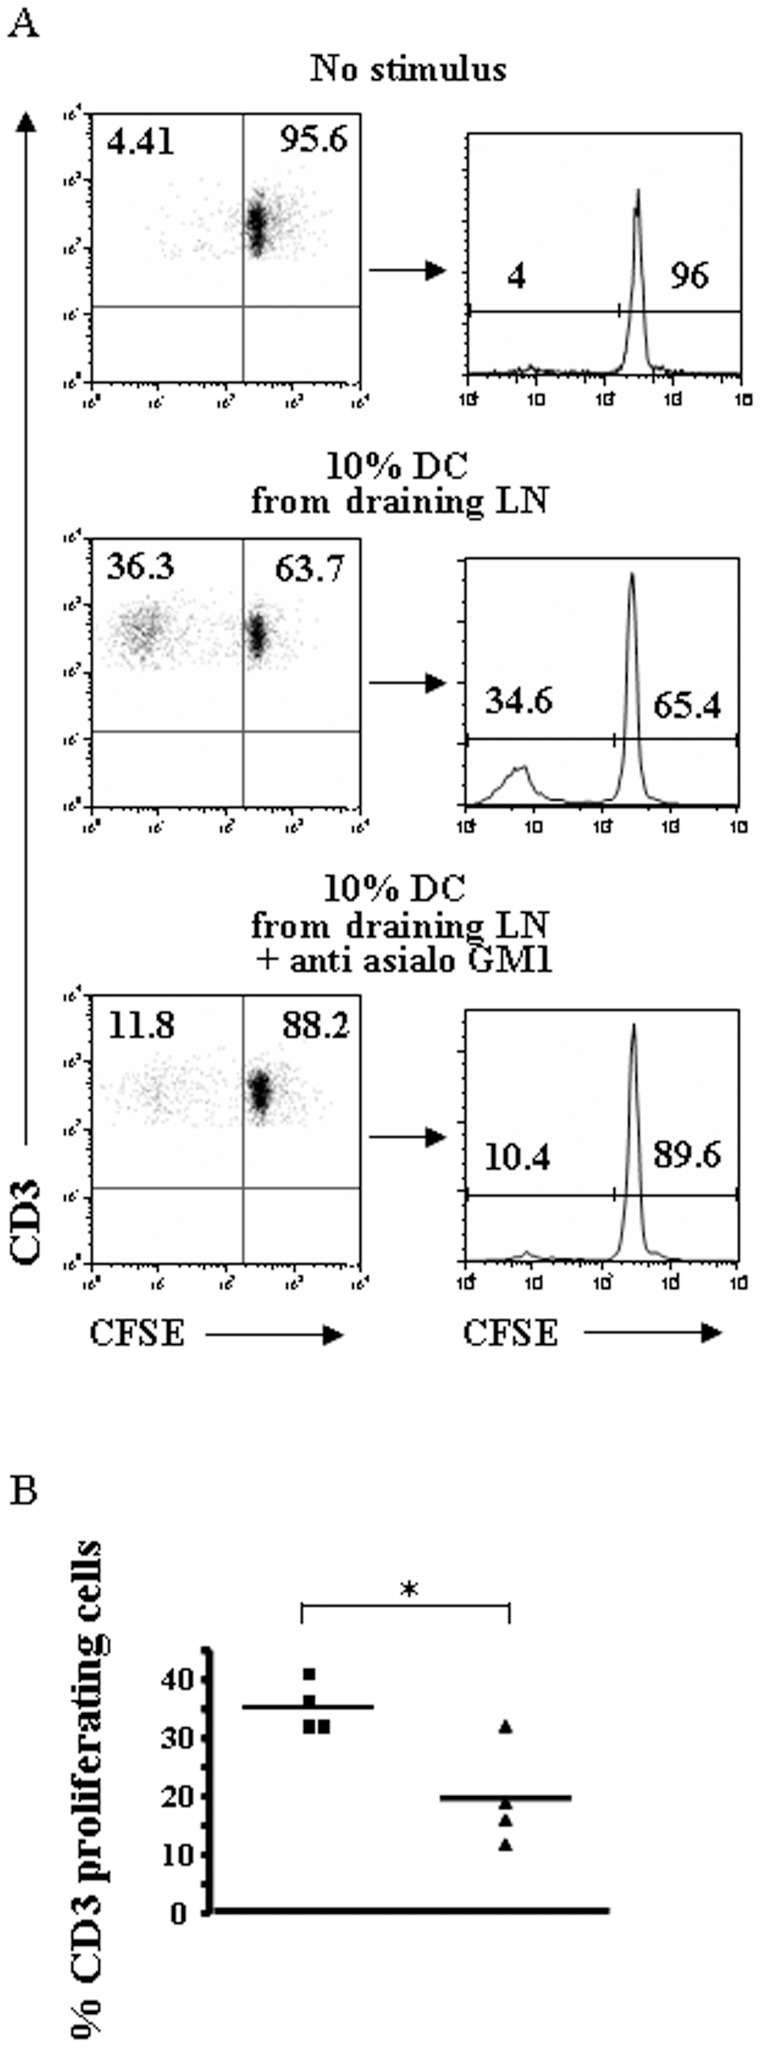
Peripheral activation of NK cells results in the selection of lymph node DCs with higher T cell activating capabilites.Draining lymph node DCs of mice injected subcutaneously with MHCnegcells were sorted and cultured in the presence of allogeneic splenocytes previously labeled with CFSE. A: Splenocytes were cultured alone (No stimulus) or with 10% of highly purified lymph node DCs from mice NK cell depleted (10% DC draining LN + anti-asialo GM1) or control (10% DC draining LN) before administration of MHC-negative target cells. CFSE dilution of the splenocytes at 6 days of culture is shown. NK cell depletion compromises the induction of proliferation by LN DCs. Data are representative of four independent experiments summarized in panel B: ▪ = 10% DC draining LN; ▴ = 10% DC draining LN + anti-asialo GM1. * =  p<0,02.